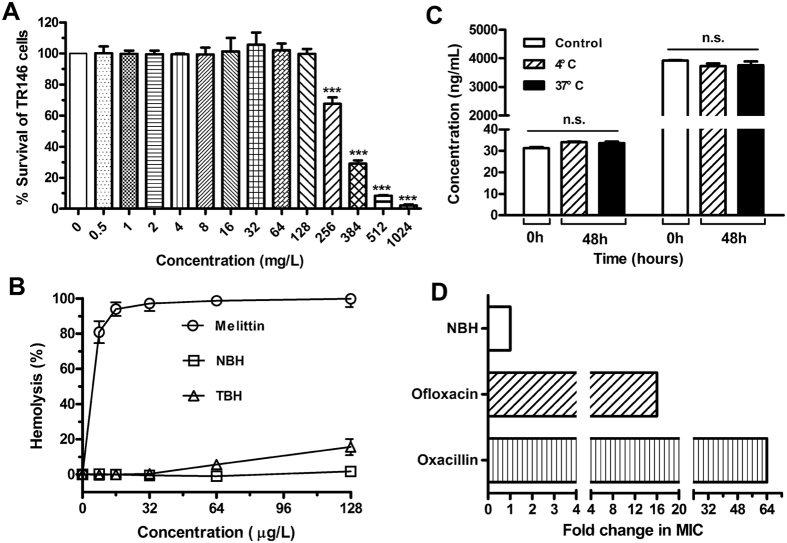
In vitro properties of NBH.(A) Cell toxicity of 0.5 mg/L to 1024 mg/L NBH determined on TR146 cells after 24 h of incubation. Each plot was obtained from a representative experiment, and data points are represented as mean ± SD of three replicates. ***P < 0.001 versus control. (B) Haemolytic toxicities of NBH (squares), TBH (triangles) and melittin (circles) determined in human red blood cells (2% haematocrit) after 1 h of incubation. Data are shown as mean ± SD values for six samples. (C) Quantification of NBH after preincubation with 95% rat plasma at 4 °C or 37 °C for 48 h. Data are represented by mean ± SD of six replicates. n.s. = P > 0.05 versus control. D. Emergence of resistance in S. aureus ATCC29213 after 15 serial passages in the presence of antimicrobials. Relative MIC is the normalised ratio of MIC obtained for the 15th subculture to MIC obtained upon first exposure.